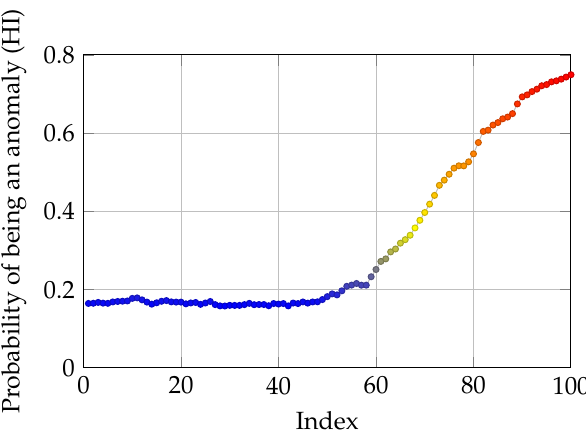
Figure 8. Probability of a signal sequence being an anomaly given the